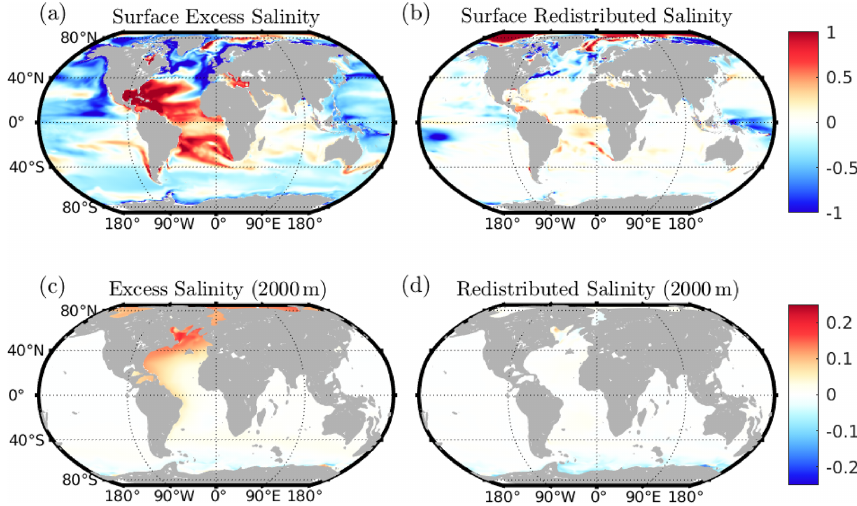
Figure 9. Maps of excess and redistributed salinity on two depth surfaces: the surface and at 2000m. Values given are the decadal mean for the decade 2090–2099. Colour axes are shared between the components at both